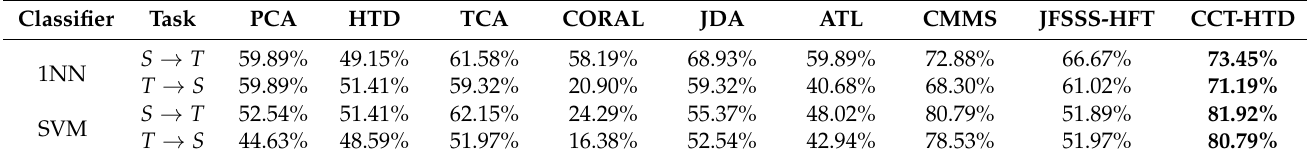
Table 6. Classification accuracies of different domain adaptation methods with 1NN and SVM using dataset 2.